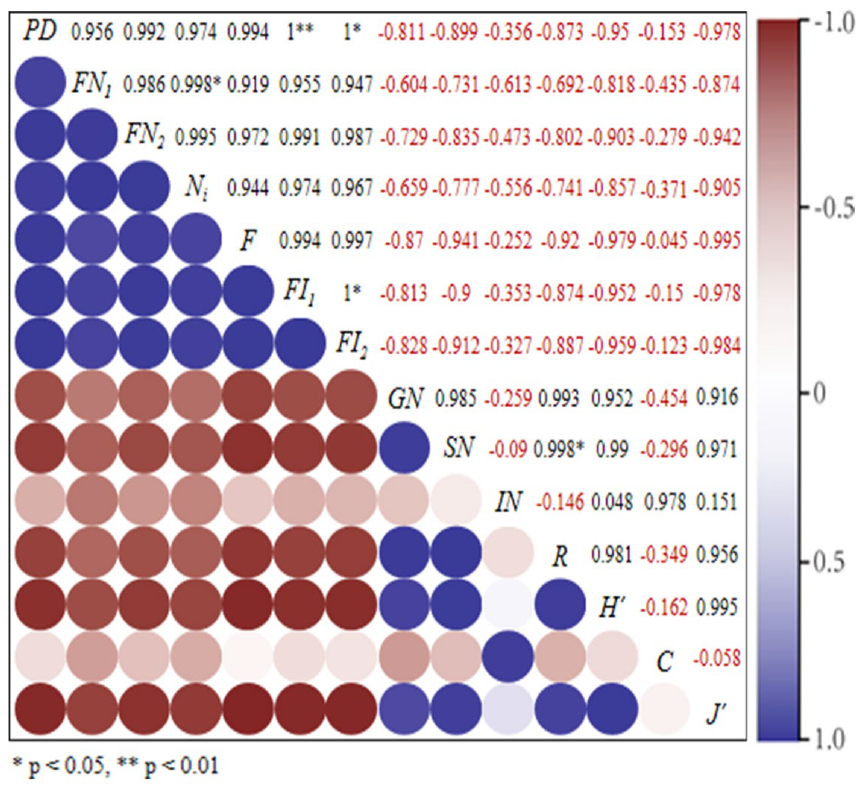
Figure 11. Correlation analysis of Erythroneurine leafhoppers habitat fragmentation and species diversity in the study area.